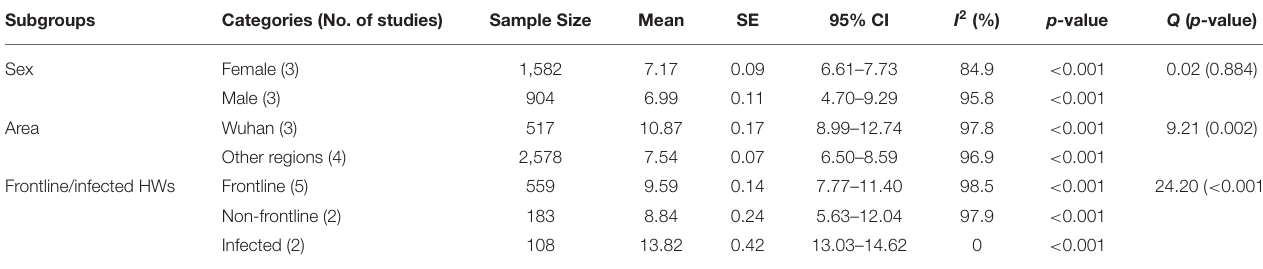
TABLE 3 | Subgroup analyses of the mean total score of PSQI.